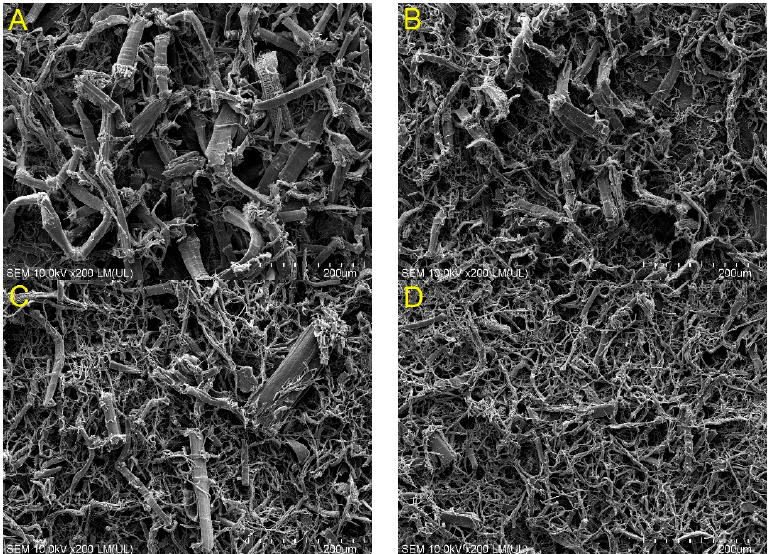
Figure 2. HF structure after extraction from PCL/HF composites (( A ) CF2.5; ( B ) CF5; ( C ) CF10; ( D ) CF20).